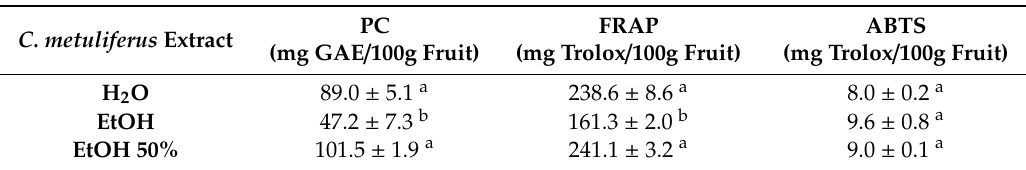
Table 1. Total phenolic content (PC) and antioxidant measurements (ABTS and FRAP) of C. metuliferus extract in di ff erent